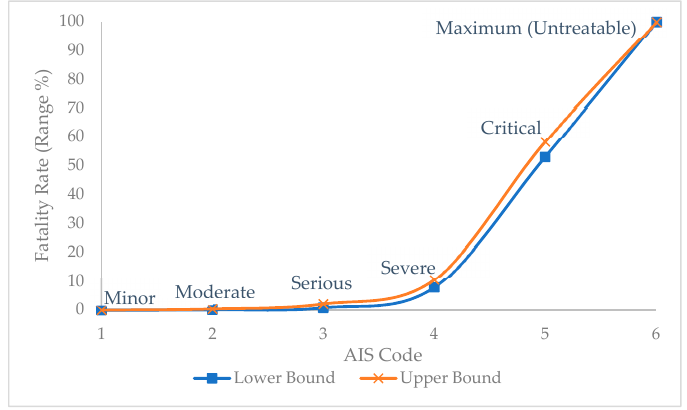
Figure 4. Severity code, adapted from Hayes et al. [44]